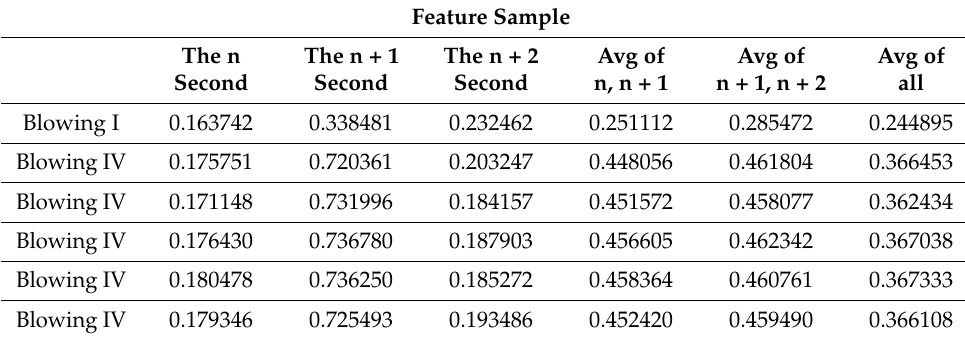
Table 4. Blowing IV is the result.